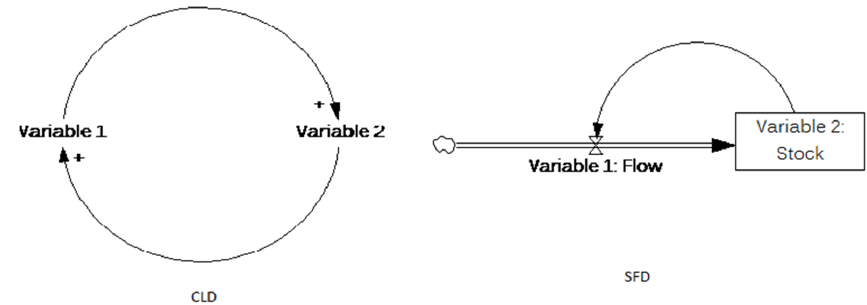
Figure 6. An example of a stocks and flows diagram (SFD) developed from a causal loop diagram (CLD).